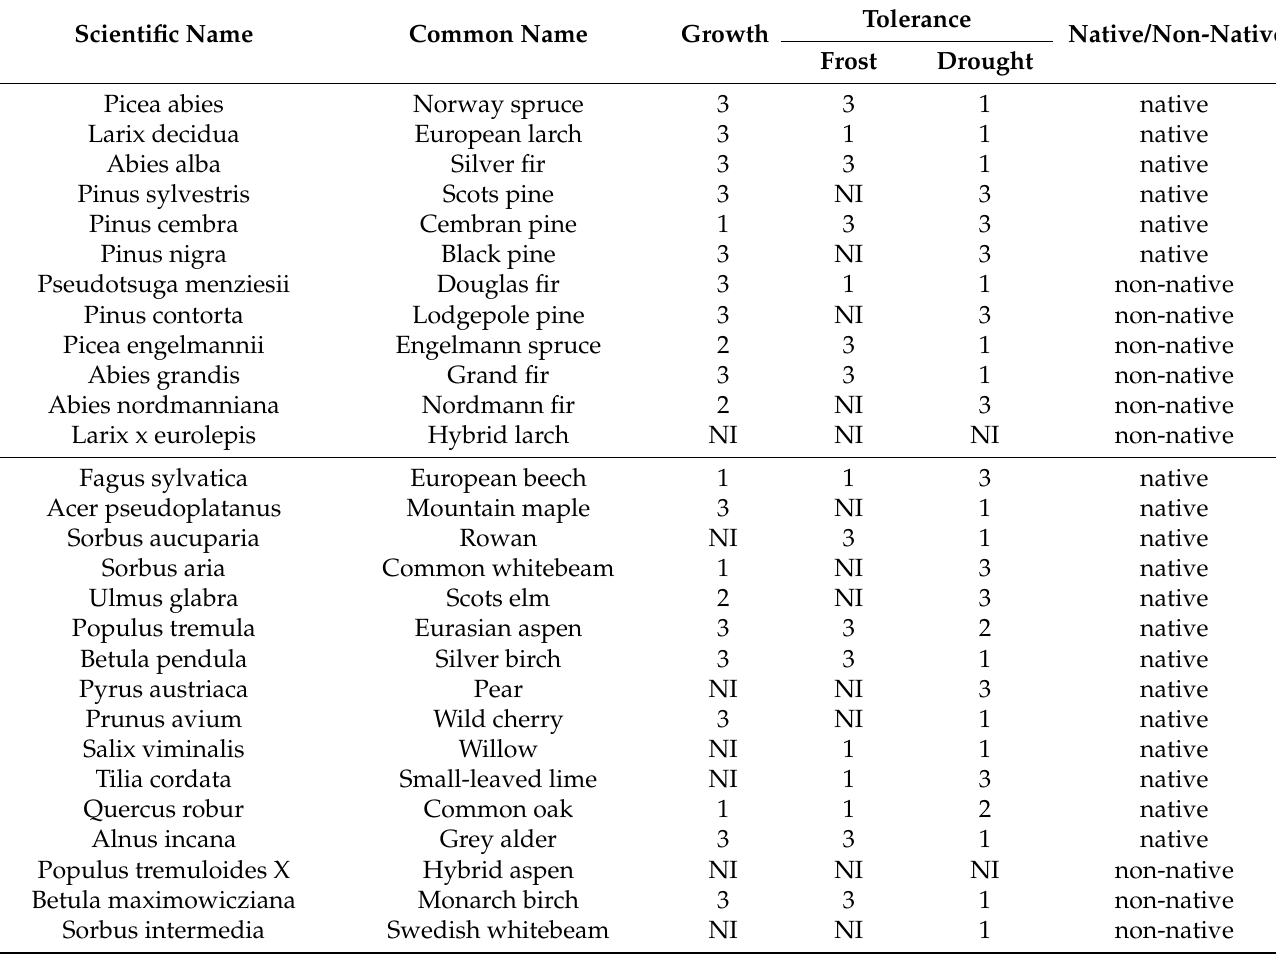
Table 2. The used tree species in the reforestation experiment together with a brief characterization of growth (3—high to 1—low) and the a priori knowledge on their tolerance towards frost and drought (3—high to 1—low). Moreover, the table shows whether the tree species are native or non-native. ‘N.I’ stands for ’no reliable information